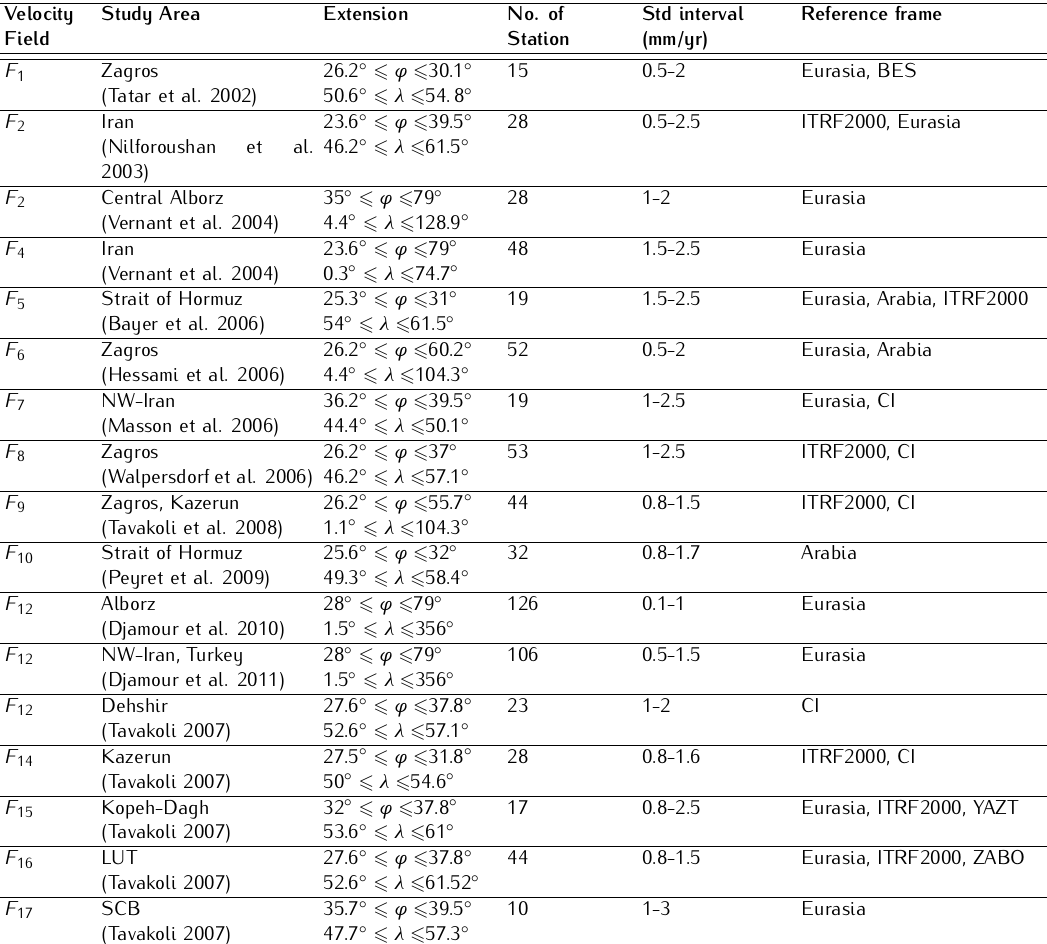
Table 1. Local GPS velocity fields used for unification of their data to have a better coverage in order to detect the possible rigid blocks. The fields are from left to right: Velocity field arbitrary names, the area of corresponding study and reference articles, Extension of data coverage, Number of stations, Standard deviation intervals and their reference frames.